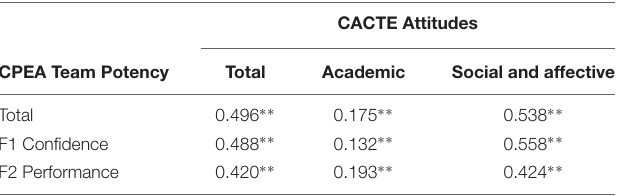
TABLE 7 | Pearson Correlations between CPEA and CACTE Factors.